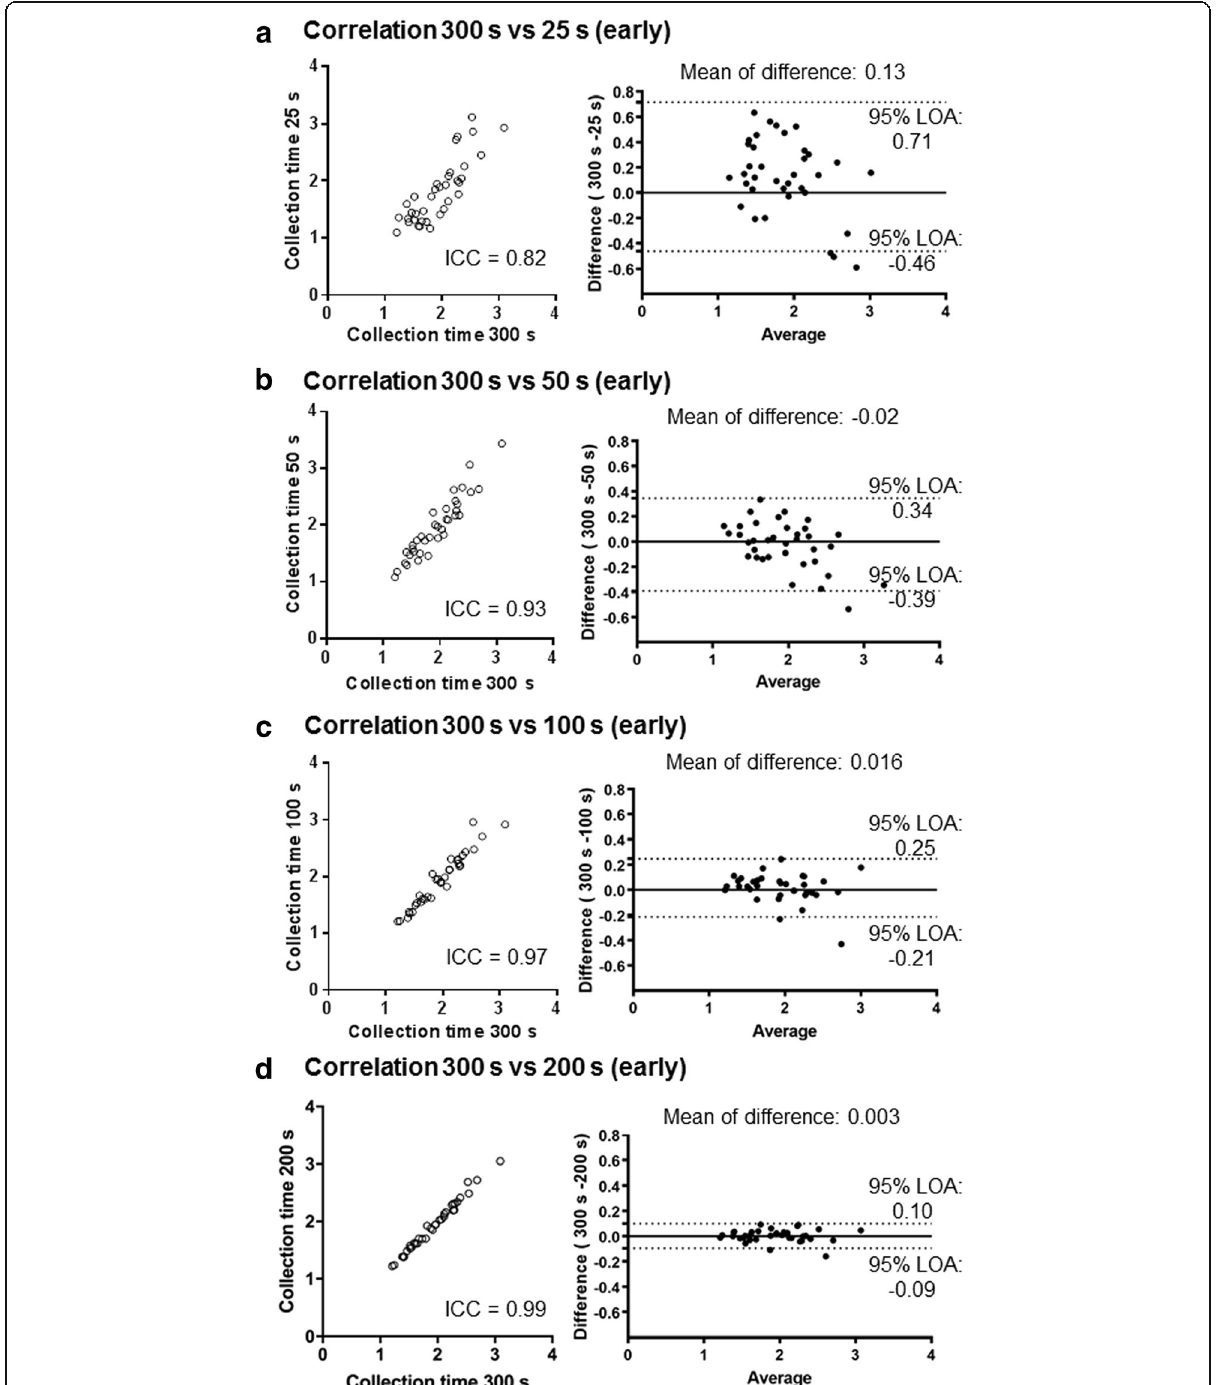
Fig. 5 Concordance of early HMRs between different collection times (clinical study). Correlations between the HMRs at early phase with collection times of 300 s ( x -axis) and 25 ( a ), 50 ( b ), 100 ( c ), and 200 s ( d ) are demonstrated. Bland-Altman analyses show the relationship of the mean ( x -axis) and difference ( y -axis) of two corresponding values. ICC intra-class correlation, LOA limit of